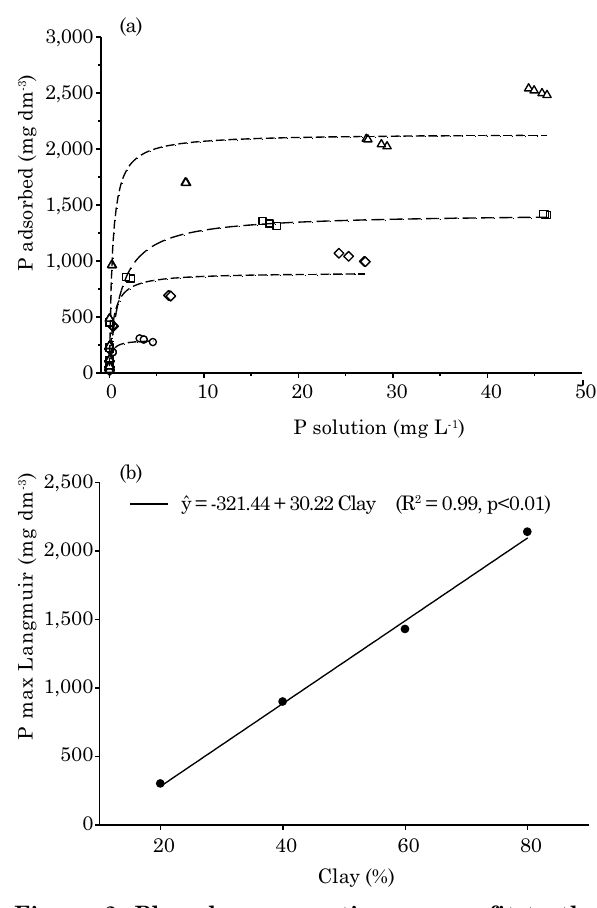
figure 2. Phosphorus sorption curves fit to the Langmuir model in soils with 20, 40, 60, and 80 % clay (a) and the relationship between the soil clay content and the maximum P sorption (Pmax) value according to the langmuir model